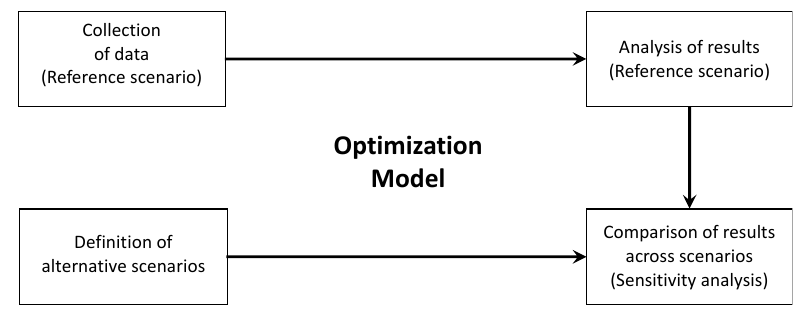
Figure 6. Methodology applied in the case study.